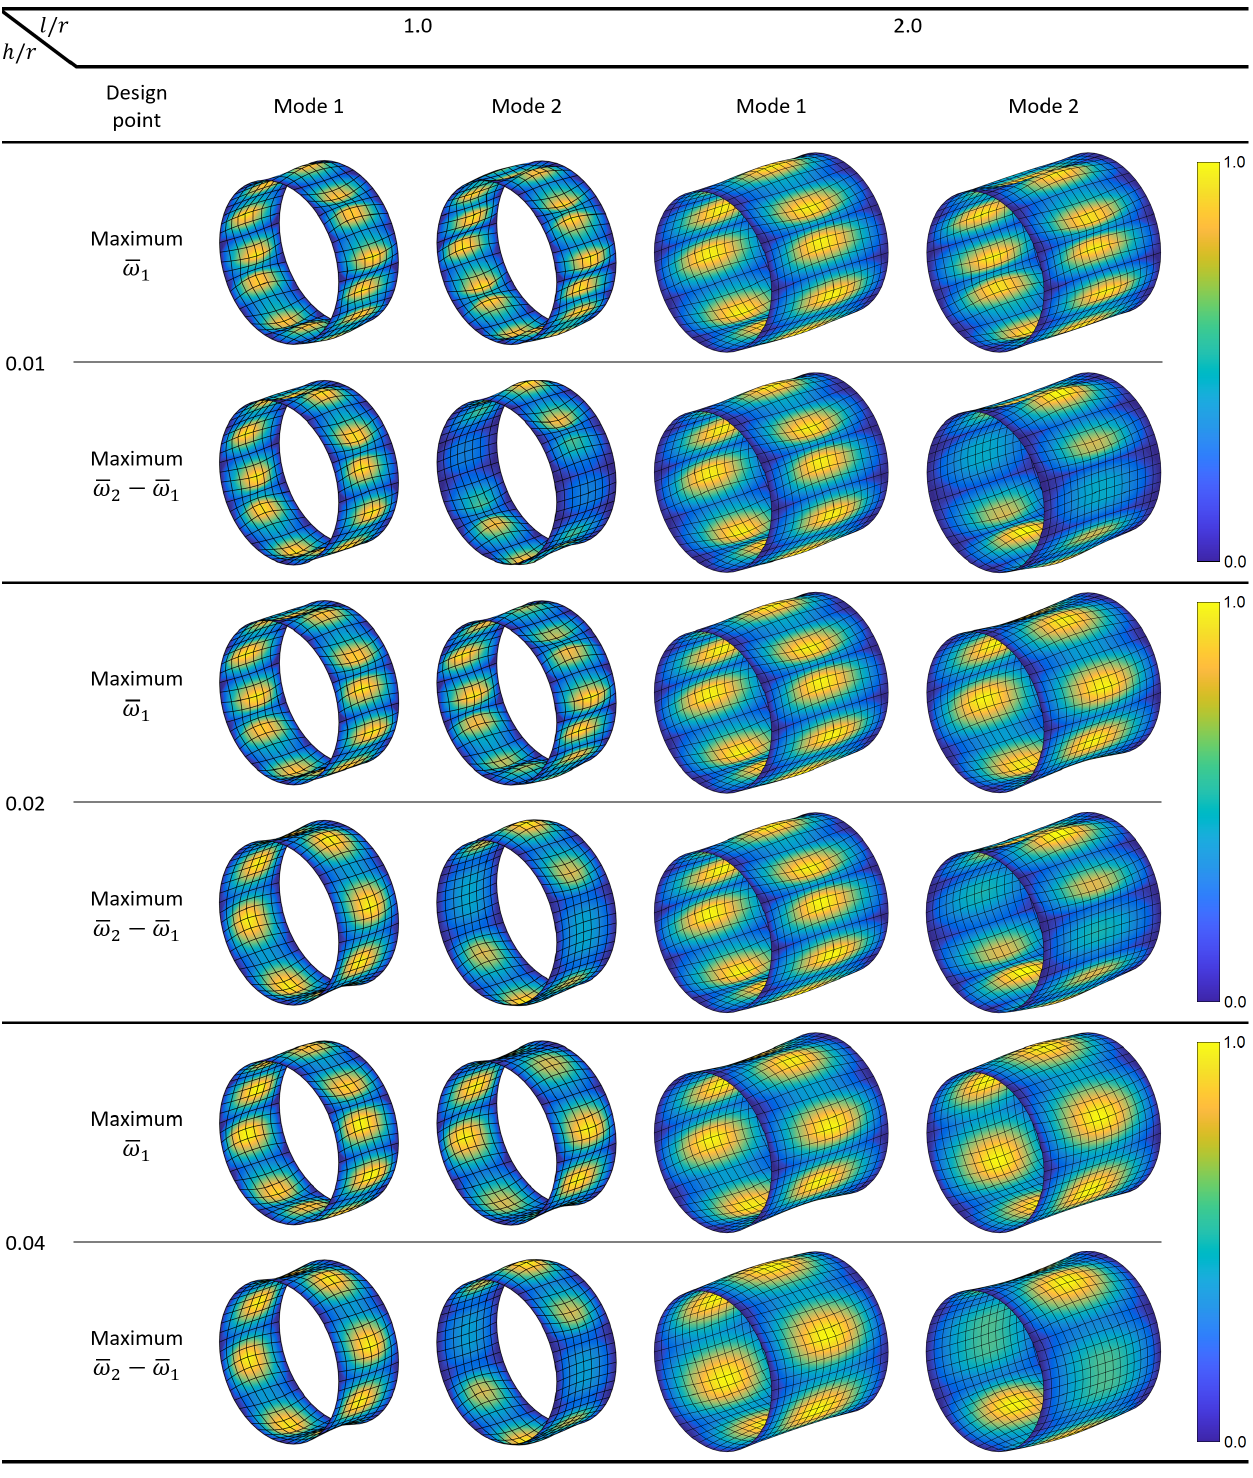
Figure 3. The first two mode shapes of simply supported circular composite cylinders optimized for maximum ω 1 and ω 2 − ω 1